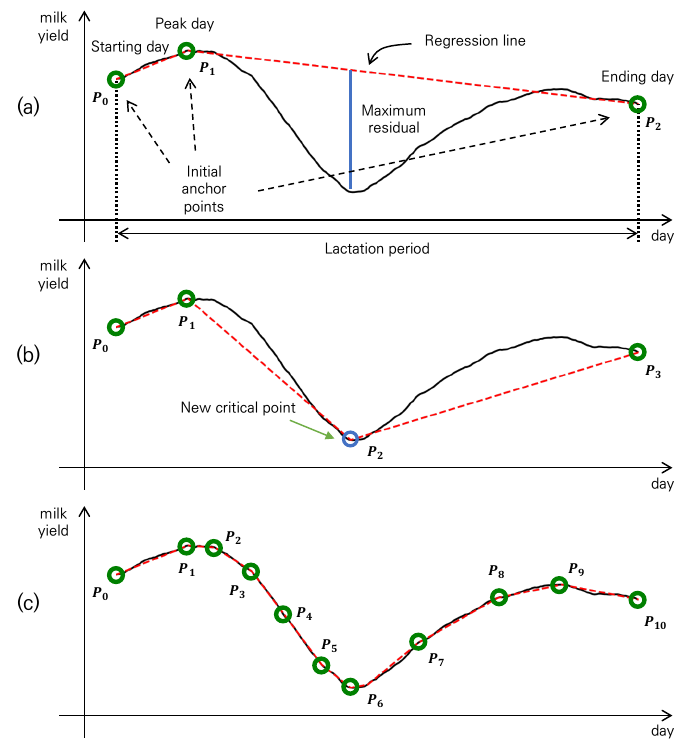
Figure 3. Fitting procedure of the PWLR model. ( a ) initial anchor points setting, ( b ) adding a new critical point, ( c ) final fitting